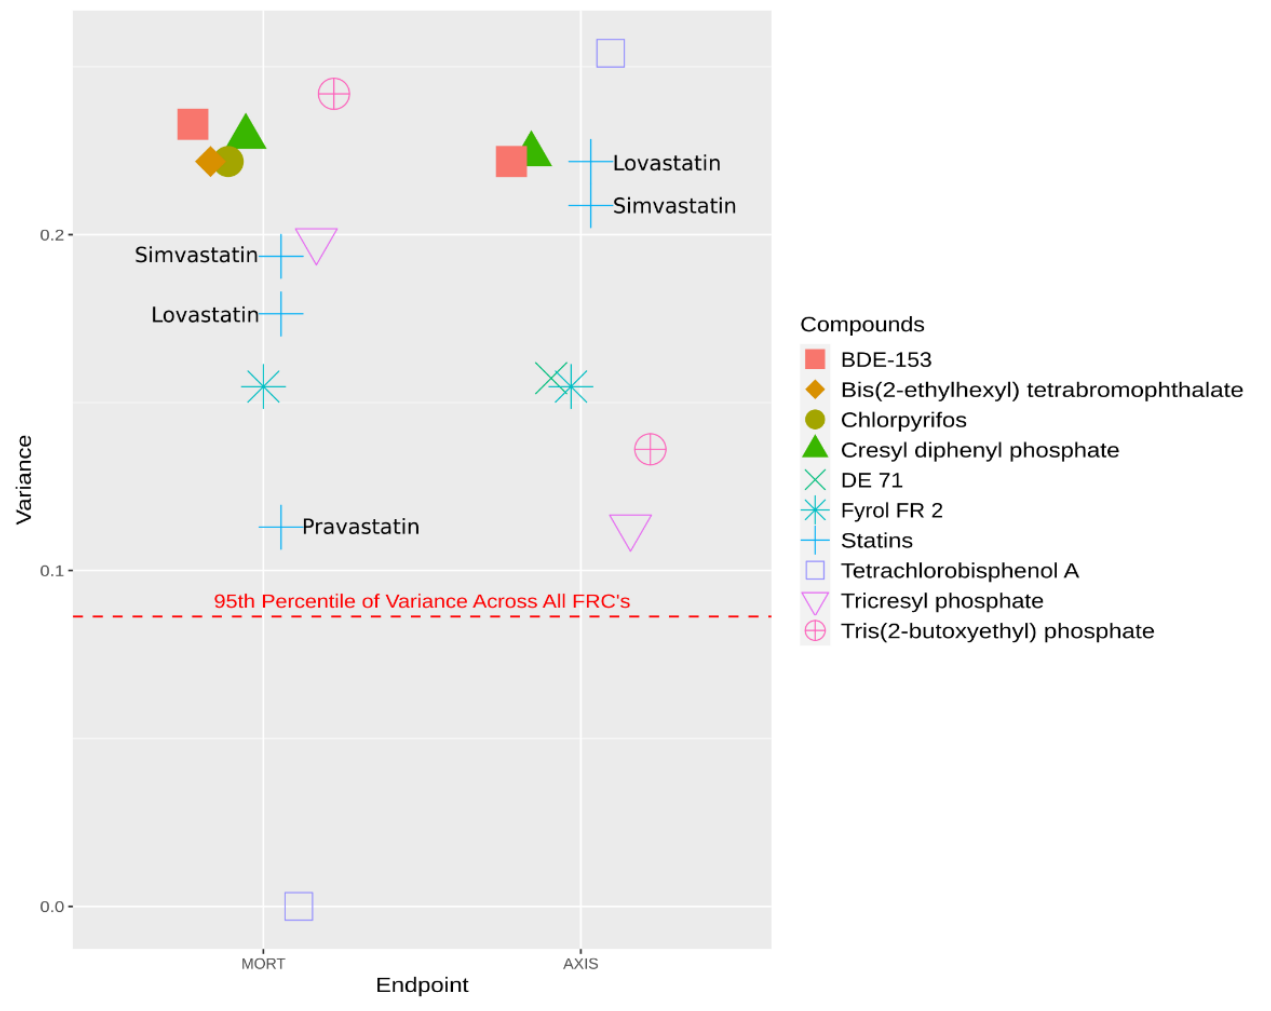
Figure 1. Variance across a high-throughput screening assay in a genetically diverse population of zebrafish across two endpoints: mortality (MORT) and bent axis (AXIS) at a chemicals lowest effect level as measured in the screening. This includes flame retardant chemicals (FRCs) that are enriched in thyroid pathways as well as statins, which are known to participate in GxE which lead to differences in susceptibility, for comparison. The statins are individually labelled. The line on the bottom represents the 95th percentile of variance in the full FRC screening. Each chemical is a different shape and color.